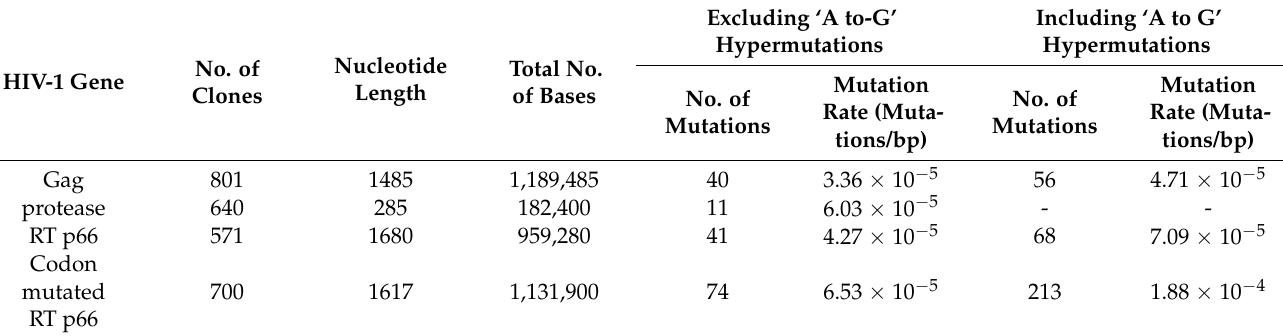
Table 1. Calculated error rates of HIV-1 RT on the respective HIV-1 genes.